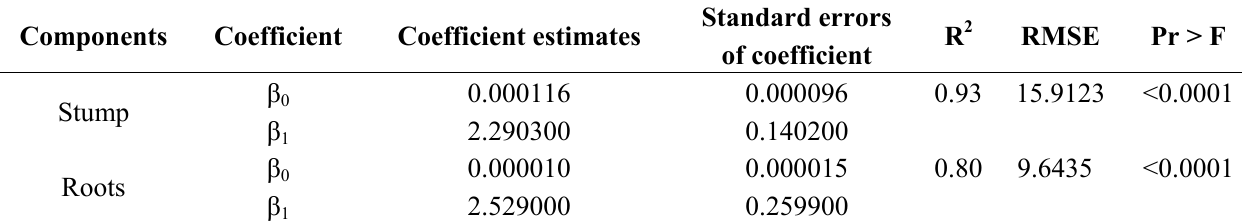
Table 4. Estimated coefficients of equation (1) for dry weight estimations of poplar stumps and roots growing on former